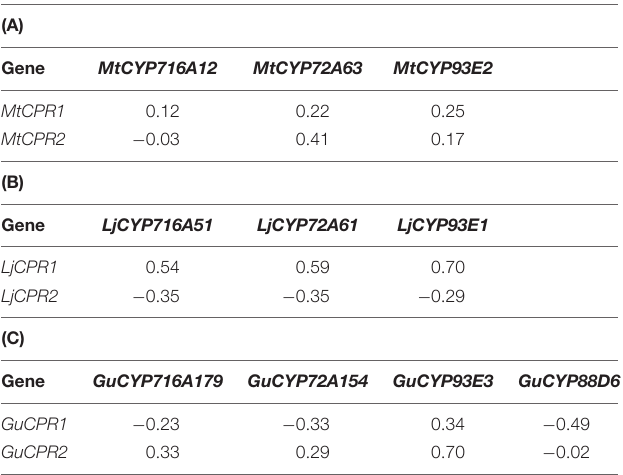
TABLE 1 | Correlation strength a between different CPR classes and CYP families in (A) M. truncatula , (B) L. japonicus , and (C) G. uralensis